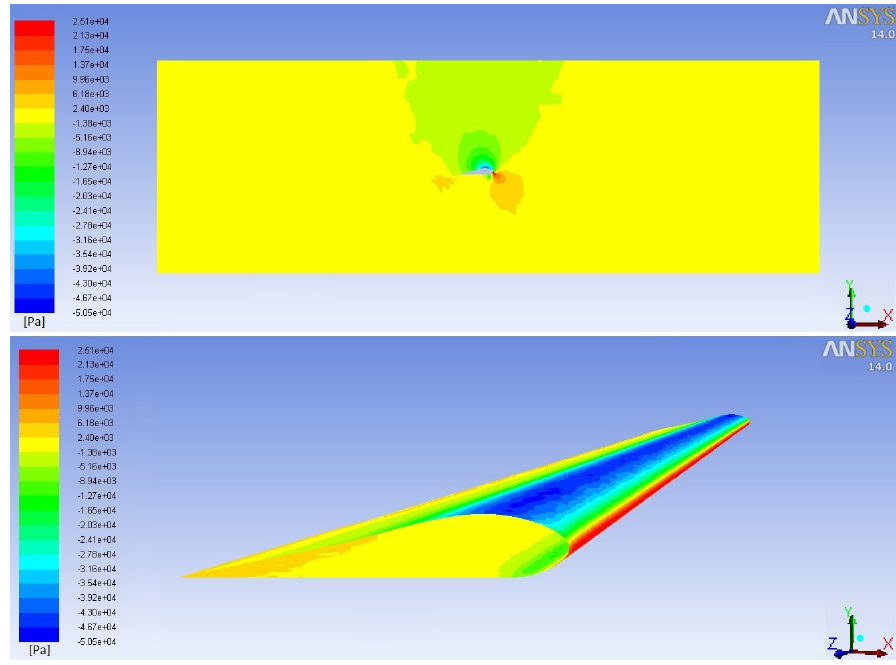
Figure 8. Variation of fluid pressure.